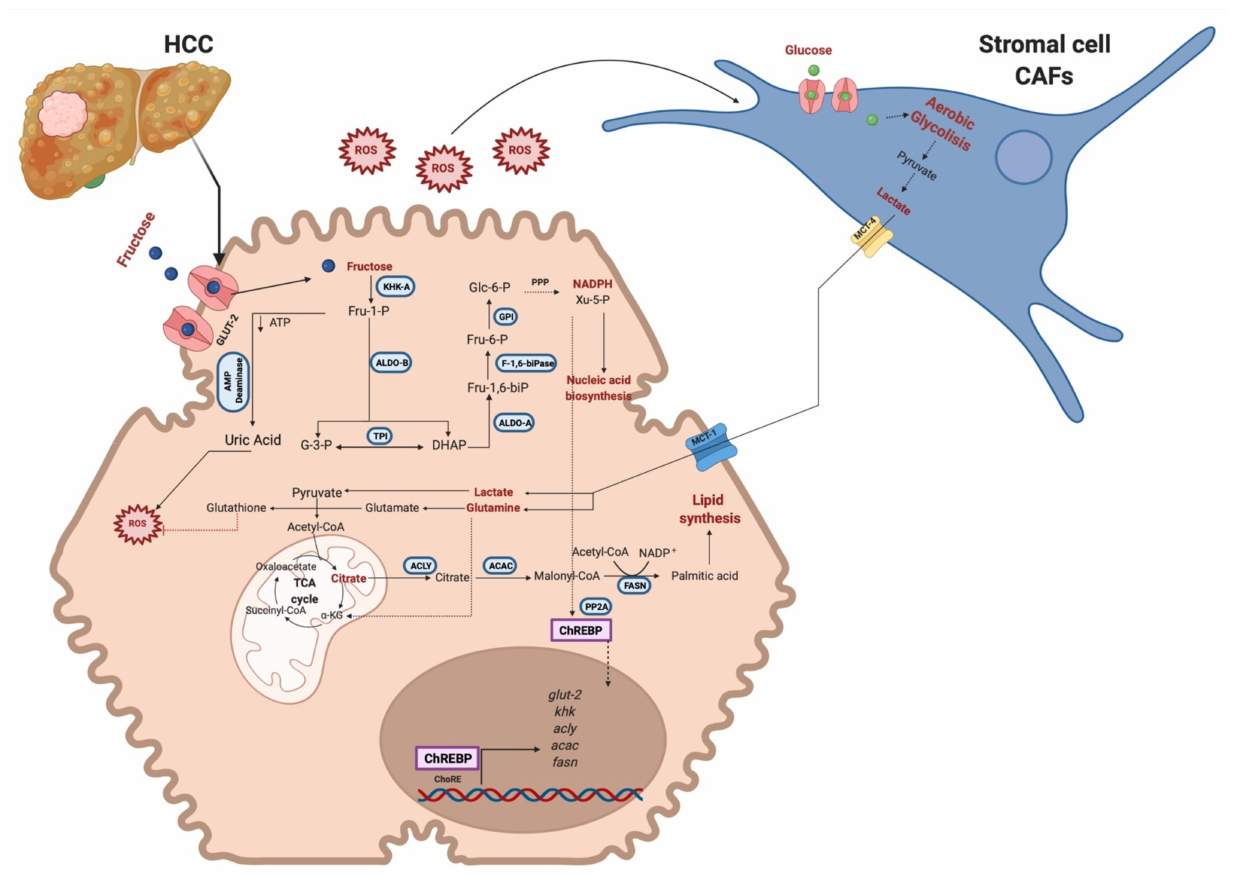
Figure 4. Fructose metabolism reprogramming in cancer cells. Fructose metabolism changes into lower levels of expression and activity of the enzymes implicated in the pathway. First, there is a change in the KHK isoform (KHK-A) to favor the enzyme’s lower fructose metabolism and kinase activity. Furthermore, ALDO-B decreases its activity. The intermediary metabolites are diverted into the PPP to obtain reduction power and Xy-5-P, enhancing ChREBP translocation into the nucleus and nucleic acid synthesis. Due to the lower KHK activity, ROS levels diminish compared to the earlier scenario but can activate CAFs. On the other hand, the reverse Warburg effect is representative of this metabolism, and CAFs render metabolic intermediaries to a cancer cell to enhance de novo lipid synthesis and reduction power. Metabolic reprogramming is implicated in improving the survival, proliferation, and metastasis of cancer cells. Red lines indicate inhibition. GLUT-2, Glucose transporter-2; KHK, Ketohexokinase; ALDO-B, Aldolase B; ALDO-A, Aldolase A; TPI, Triosephosphate isomerase; PFK1, Phosphofructokinase; GPI, Glucose 6 phosphate isomerase; HK, Hexokinase; ACLY, ATP citrate lyase; ACAC, Acetyl-CoA carboxylase; FASN, Fatty acid synthase; PP2A, protein phosphatase 2A; ChREBP, carbohydrate response element-binding protein; ChoRE, carbohydrate response elements. Created with